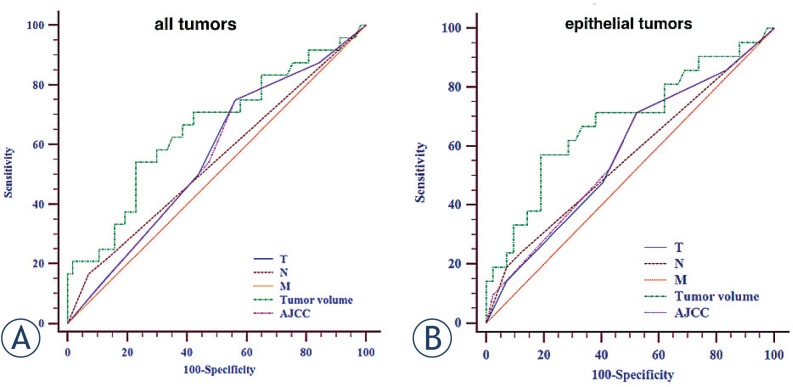
Multiple receiver operating characteristic (ROC) curves for the sum of covariates for all patients (A) and for the squamous cell carcinoma and adenocarcinoma subgroups (B) demonstrating that radiologic tumour volume has the largest area under the curve (AUC).